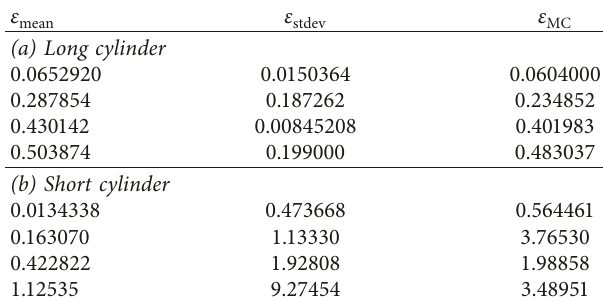
Table 5: The errors between eigenvalues computed by collocation ) and Monte Carlo ( ω 2 ) methods. The four smallest eigen- ( ω 2 C MC values of the long (a) and short (b)